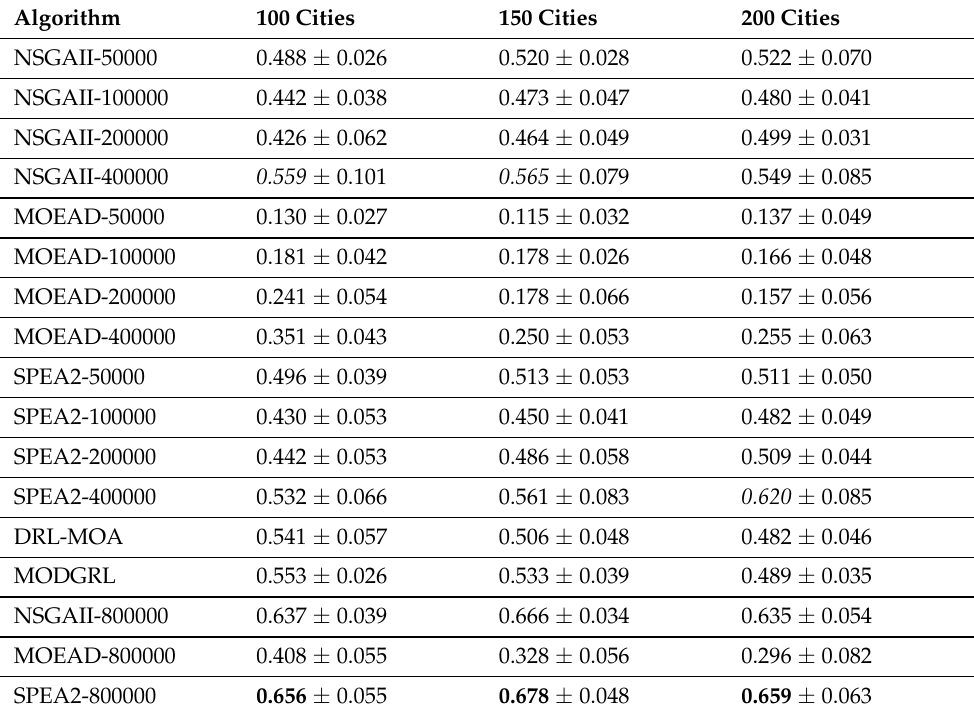
Table A3. Comparison of CPF values. The maximum values are the best. The bold values are the best ones among all